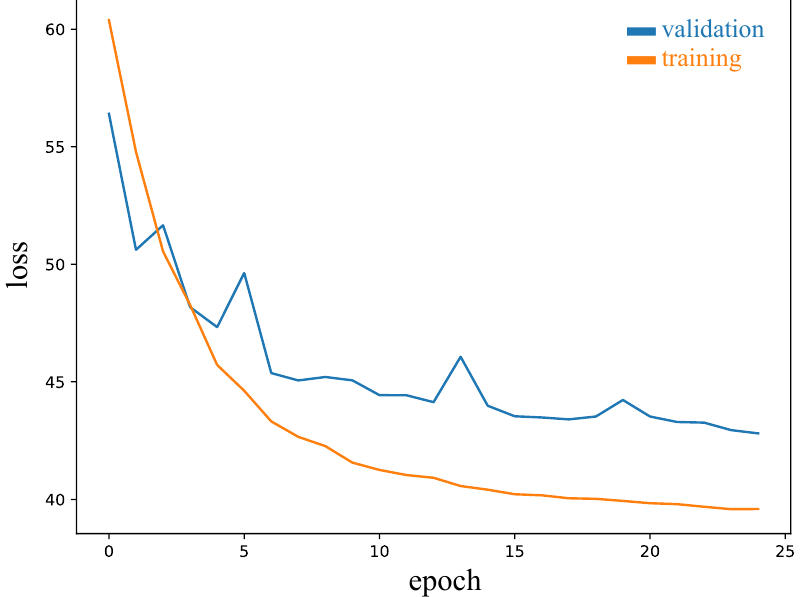
Figure 5. Training the model with 50 students with 5 genuine signatures each. The graph represents how the loss value in the y-axis varies with the number of epochs in the